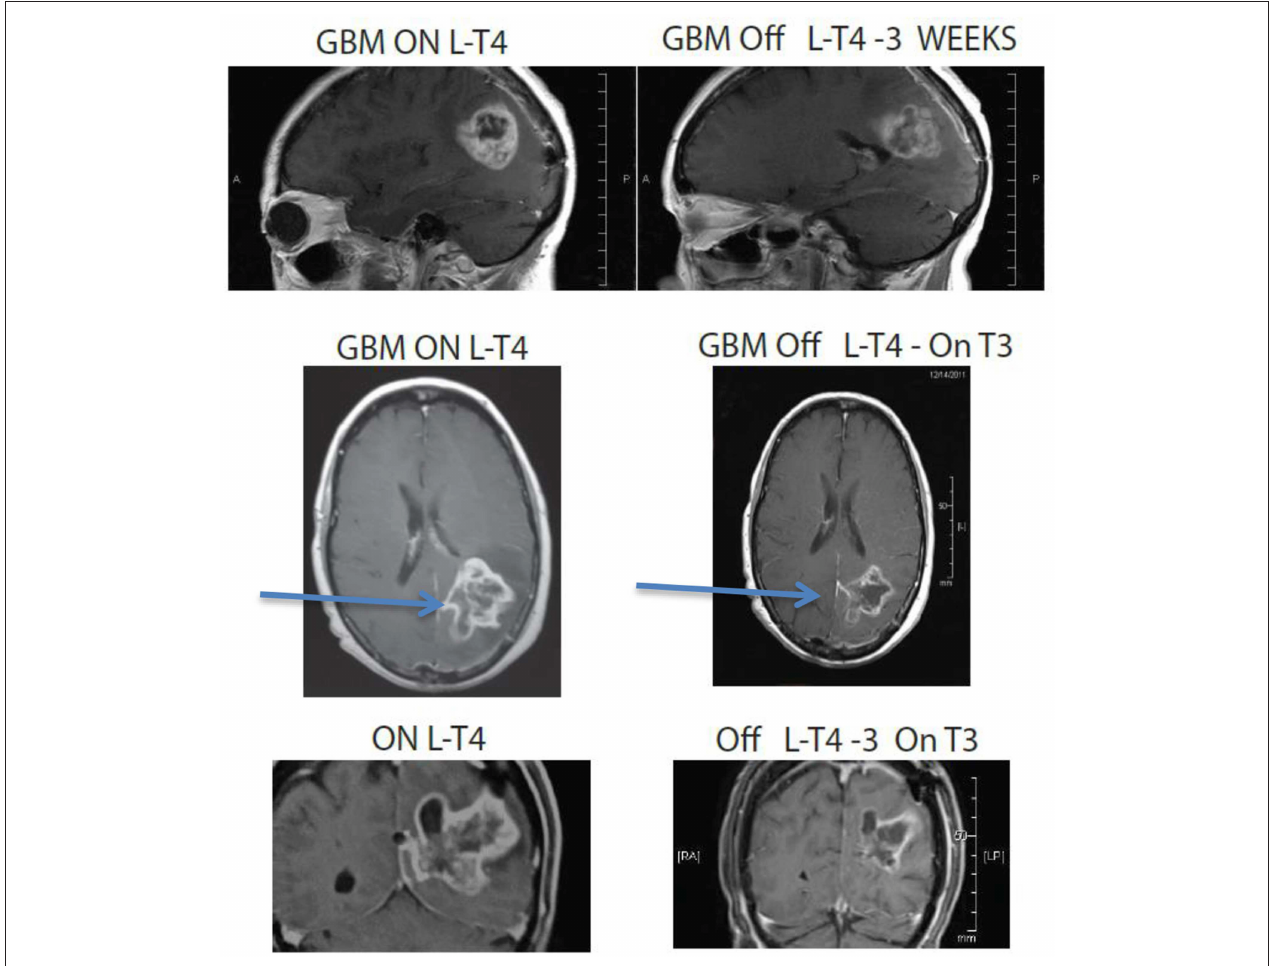
FIGURE 4 | MRI images of a 67 year old female patient who was deteriorating neurologically with hemiplegia unresponsive to high dose dexamethasone. Discontinuation of L-T4 was followed within 1 week by significant clinical improvement and tumor regression. Arrows point to tumor mass, showing reduction in size in all dimensions following cessation of exogenous L-T4.